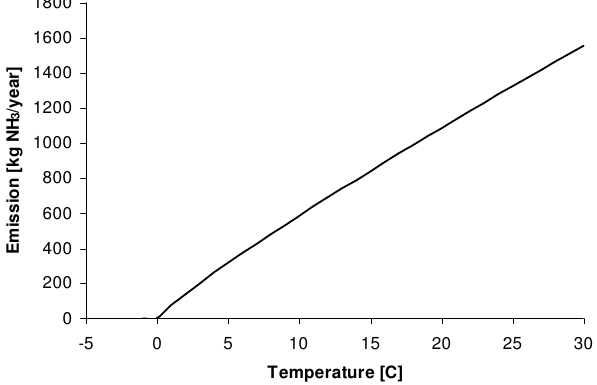
Fig. 1. Annual ammonia emission from storage facilities as function of temperature from a pig production facility with 1000 animals and production methods as in Denmark.